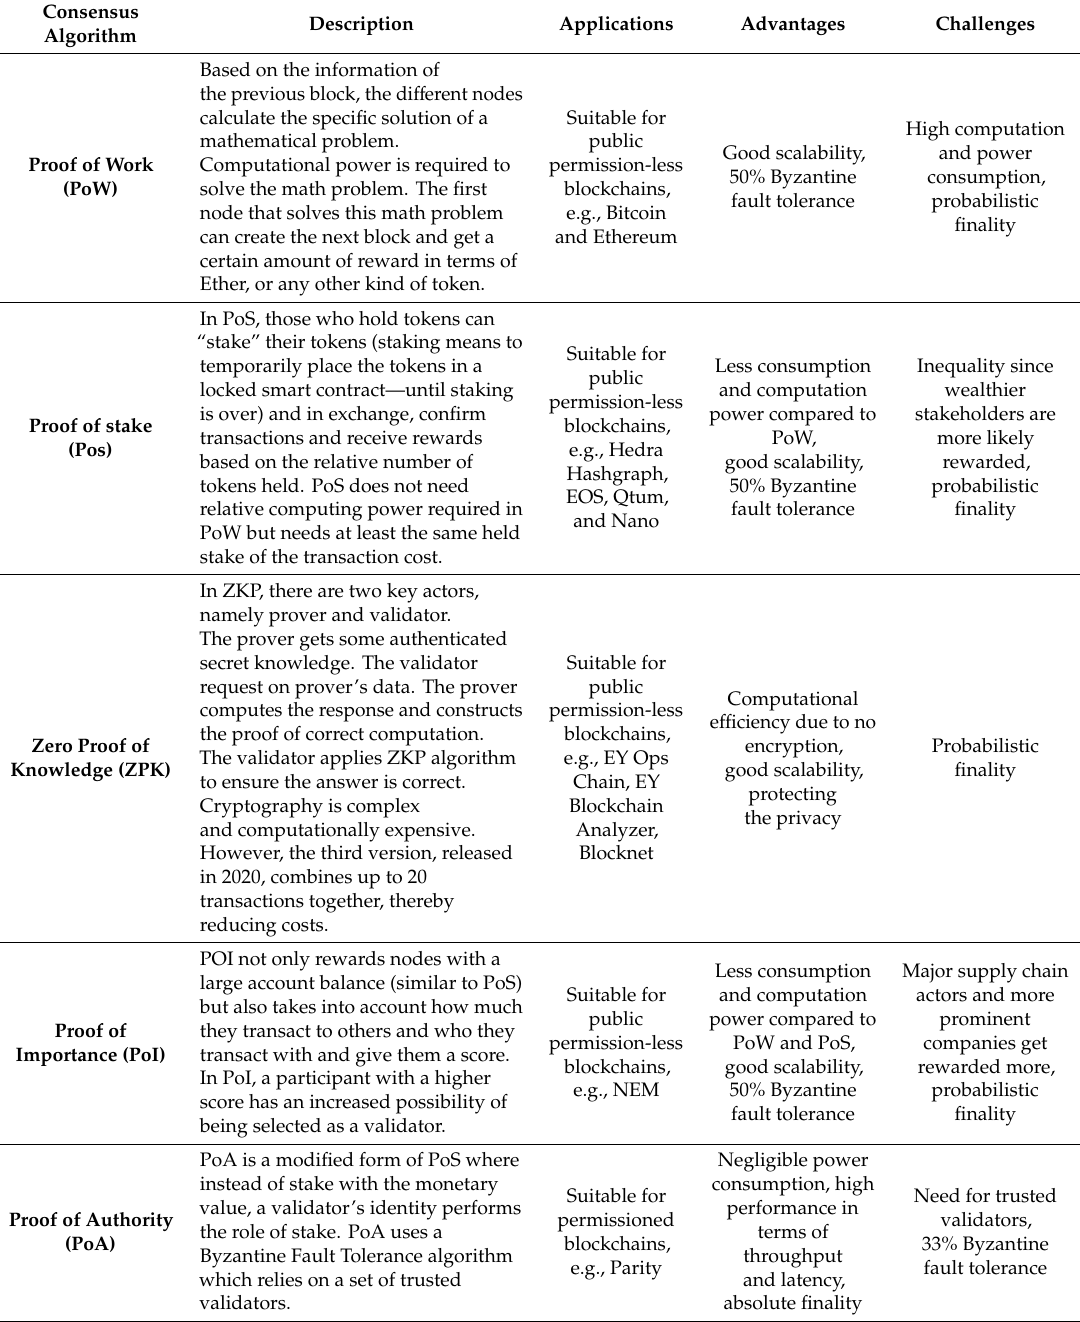
Table 2. Comparison of consensus algorithms (developed by the author from the studies in References